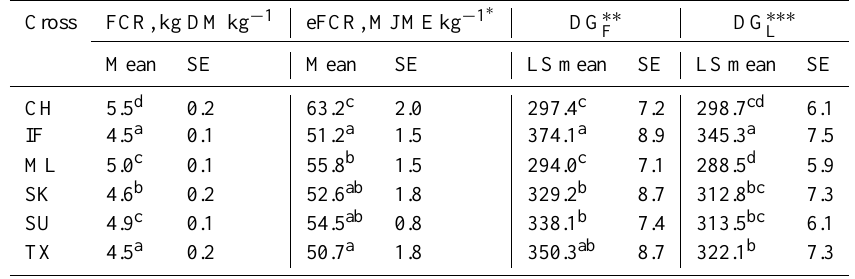
Table 3. Effect of cross on FCR, eFCR, DG during the fattening period and over the lifetime of fattening lambs. Cross FCR, kg DMkg −